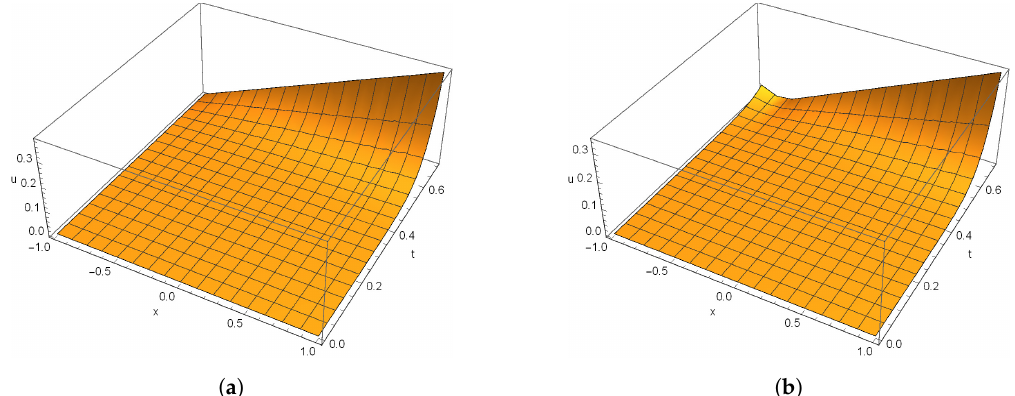
Figure 8. The absolute errors between the exact solution and the seventh order solution for α = 1, z = 0.5 with ( a ) y = 0.5 and ( b ) y =